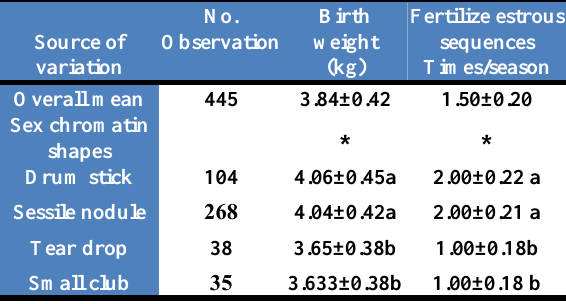
Table, 4: Effect of sex chromatin shapes on birth weight (kg) and fertilizes estrous